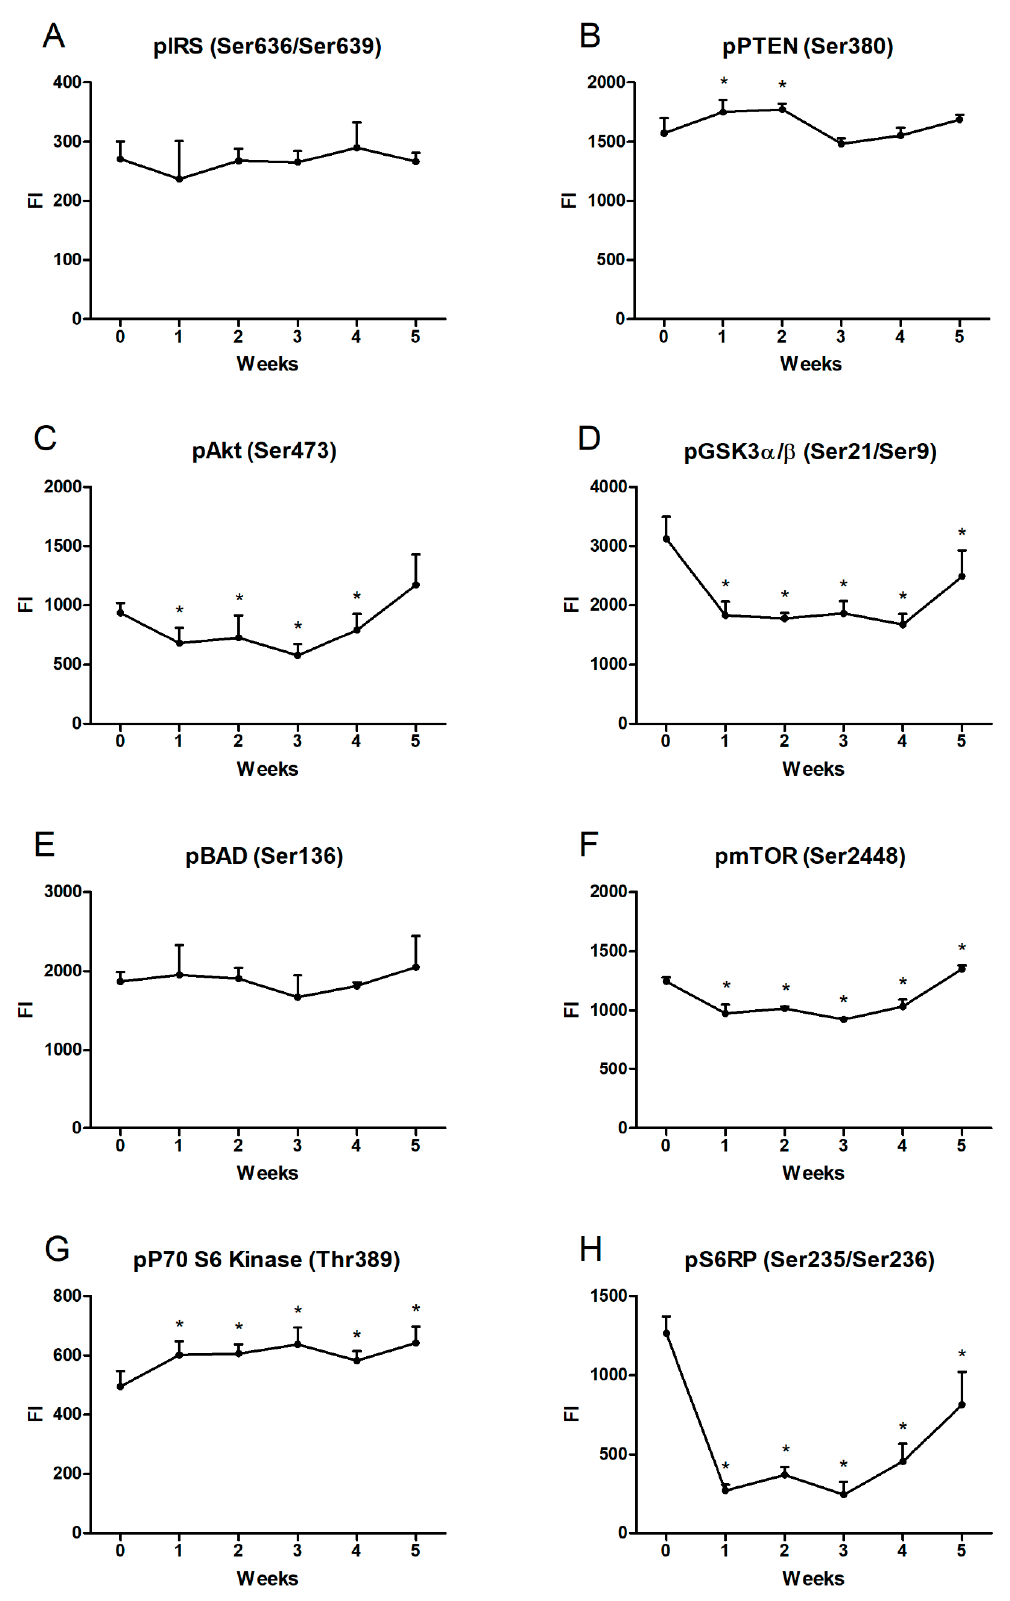
Figure 5. The level of phosphorylated proteins from insulin signaling pathway, i.e., ( A ) insulin receptor substrate (pIRS(Ser636/Ser639)), ( B ) phosphatase and tensin homolog (pPTEN(Ser380)), ( C ) protein kinase B (pAkt(Ser473)), ( D ) glyco- gen synthase kinase 3 α / β (pGSK3 α / β (Ser21/Ser9)), ( E ) Bcl-2-associated agonist of cell death (pBAD(Ser136)), ( F )